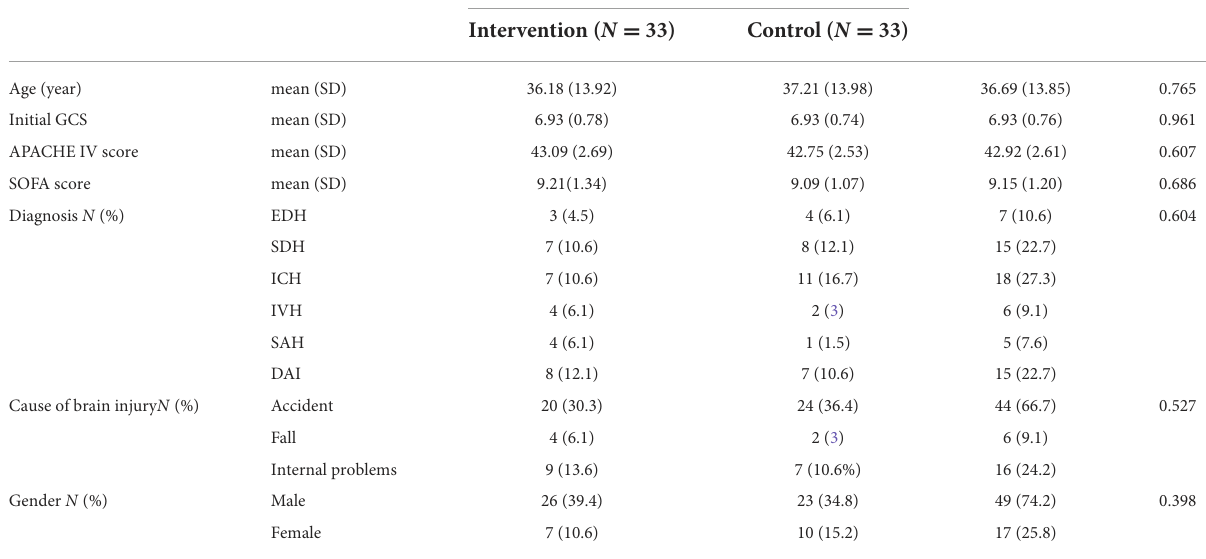
TABLE 1 Demographic characteristics of the ICU patients ( N = 66) a . Variable